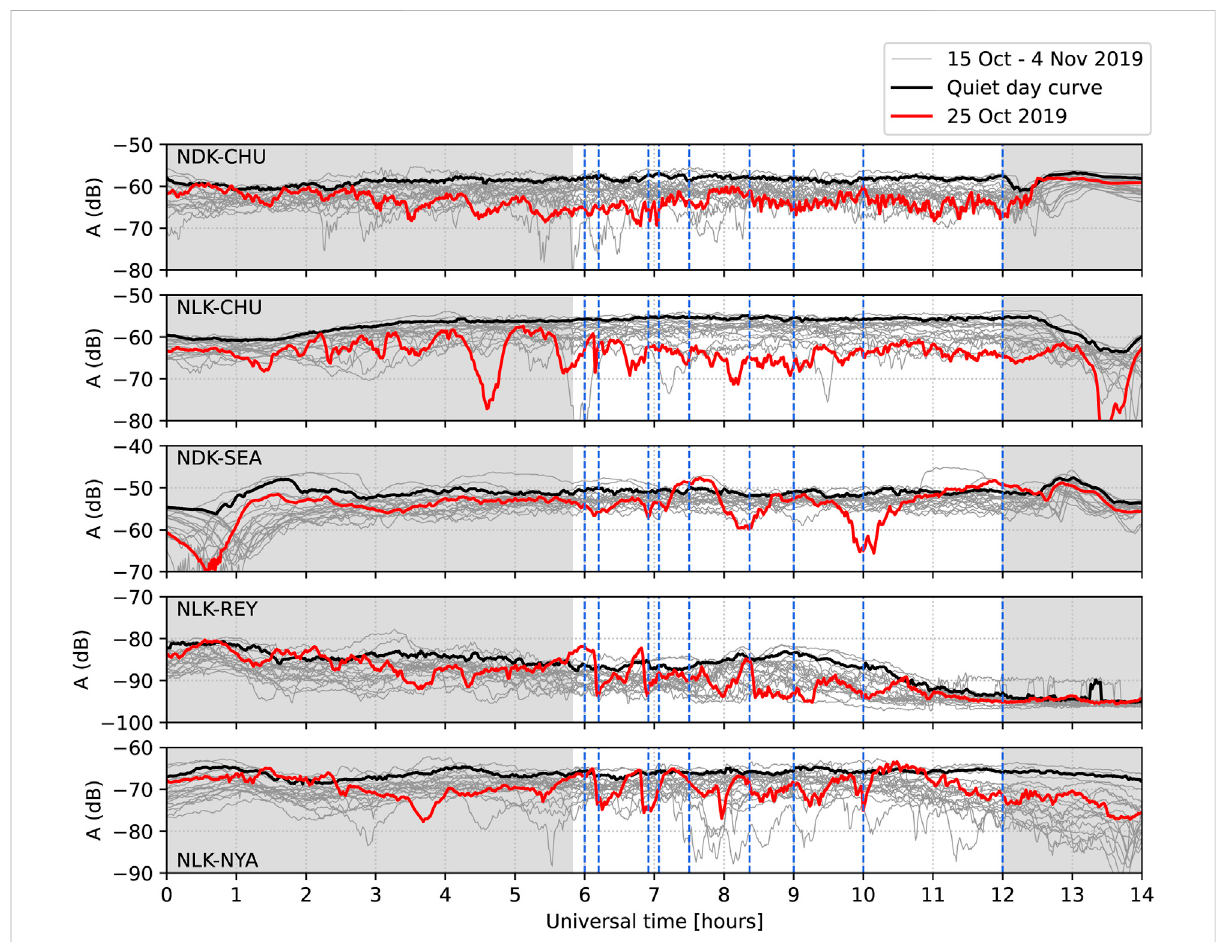
FIGURE 6 Amplitude variation of narrowband VLF observations corresponding to the NDK – Churchill (CHU), NLK – Churchill, NPM – Churchill, NLK – Reykjavík (REY) and NLK – Ny Ålesund (NYA) propagation paths. The red line shows the data from the event day (25 October 2019) and the grey lines show data from the 21-day period 15 October to 4 November 2019. The quiet day curve is shown in black. The white shading indicates the substorm event. The blue dashed lines correspond to the time instants shown in Figure